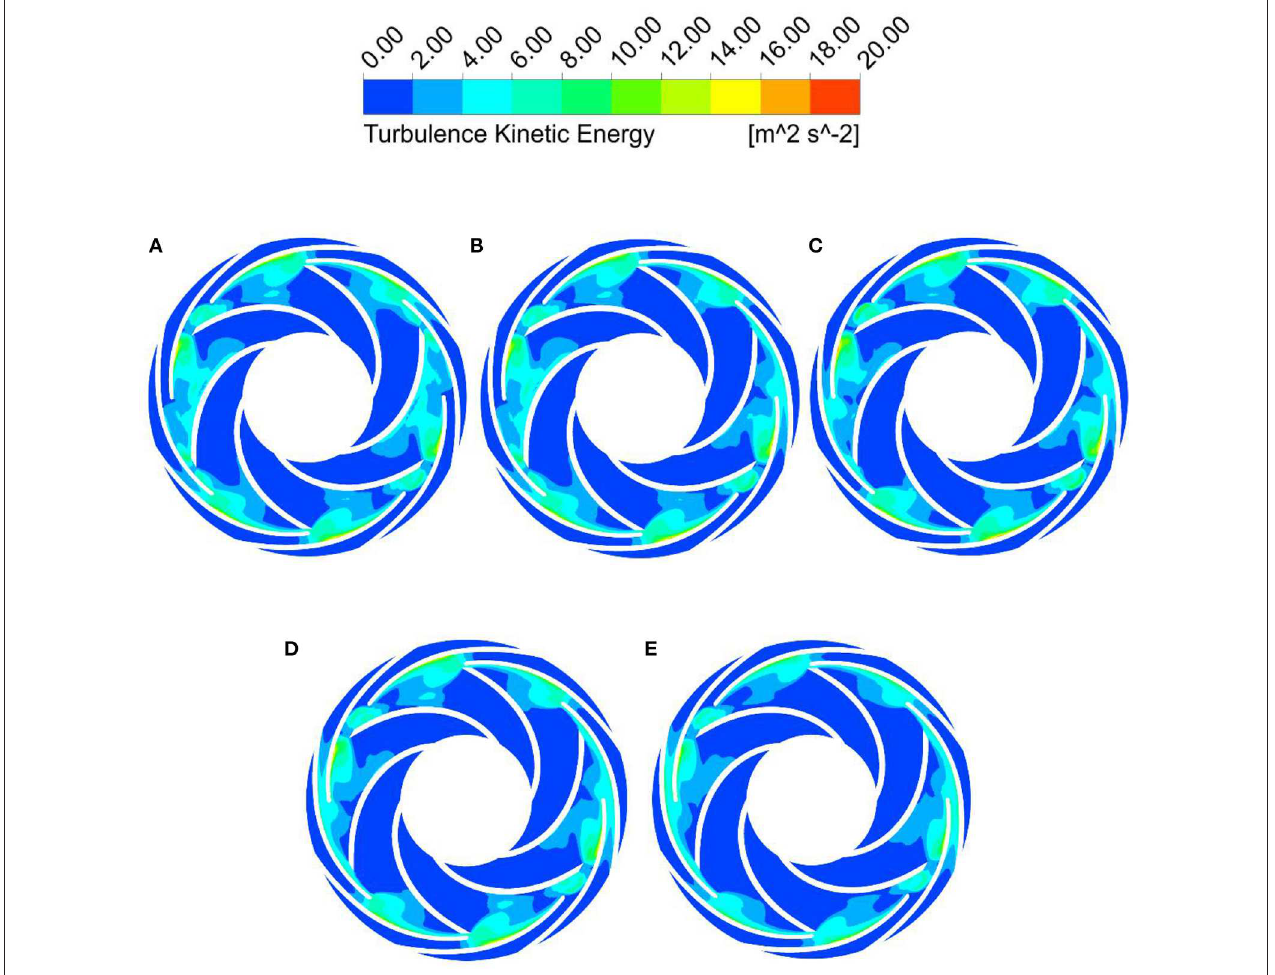
FIGURE 19 | Turbulent energy distribution of the second stage impeller in the start-up process of the open-valve transition. (A) t = 0.93s, (B) t = 1.36s, (C) t = 1.83s, (D) t = 2.35s, and (E) t = 3.10s.